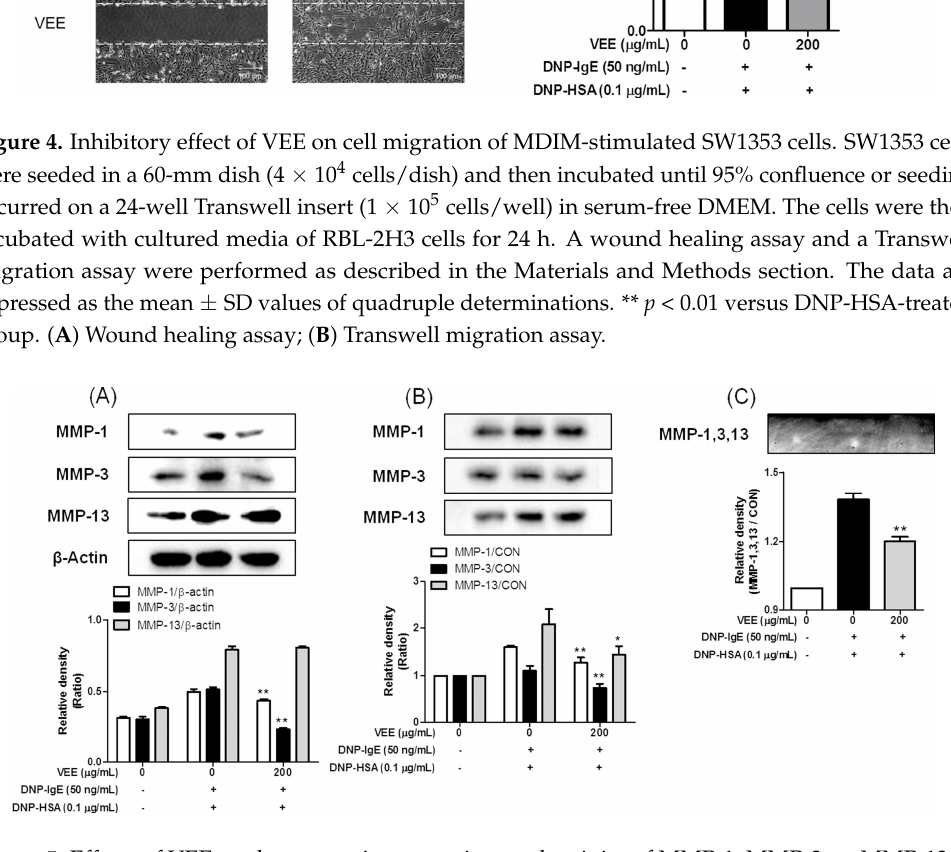
Figure 5. Effects of VEE on the expression, secretion, and activity of MMP-1, MMP-3, or MMP-13 in MDIM-activated SW1353 cells. SW1353 cells were seeded on a 60-mm dish and then incubated until 95% confluence. Precipitation of secreted proteins, a zymography assay, and immunoblotting analysis were determined as described in the Materials and Methods section. Similar results were obtained in three independent experiments. * p < 0.05 and ** p < 0.01 versus DNP-HSA-treated group. ( A ) Cell lysate; ( B ) cultured media; ( C ) zymogram.